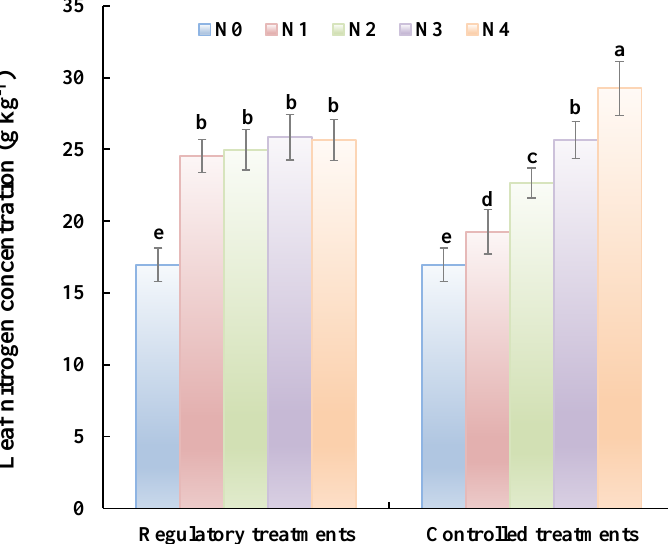
Figure 5. Leaf nitrogen concentrations for trees receiving different treatment at fruit maturity in 2016. For the controlled treatments, leaf N nitrogen concentrations increases as the N application rate increases, and there are significant differences in concentration amongst the treatments. In contrast, leaf N concentrations from trees receiving the regulatory treatments tended to be similar across treatments.